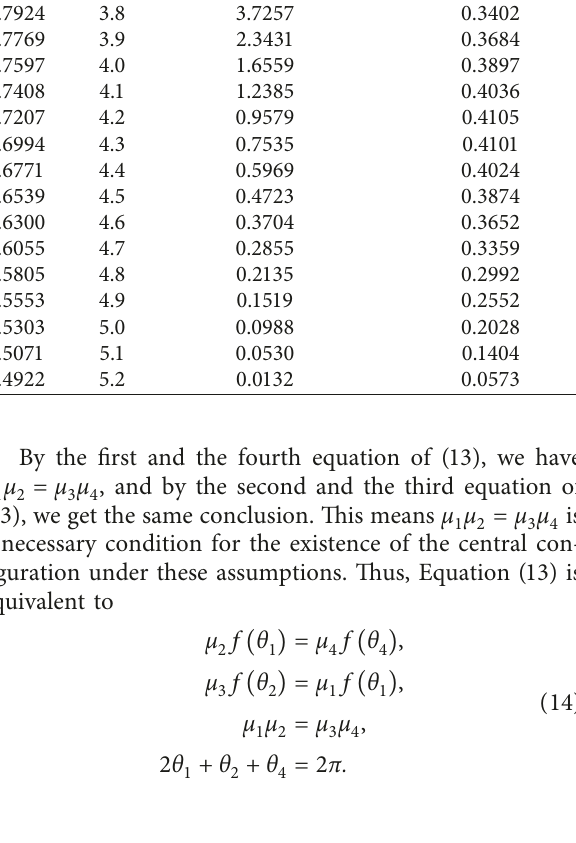
+ μ ) / ( μ + μ ) , and , θ , ( μ 1 2 1 4 2 3